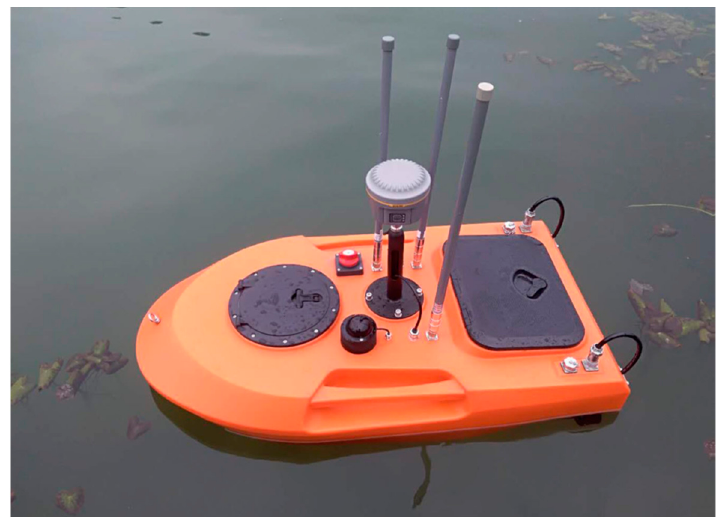
Figure 2. Surface marine drone.